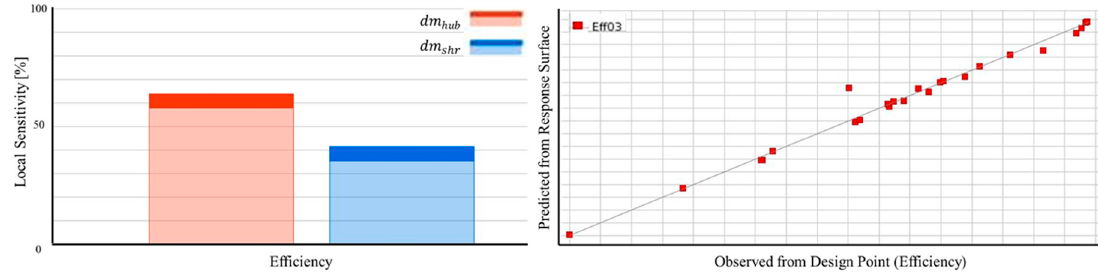
Figure 11. Local sensitivity and goodness-of-fit for efficiency.